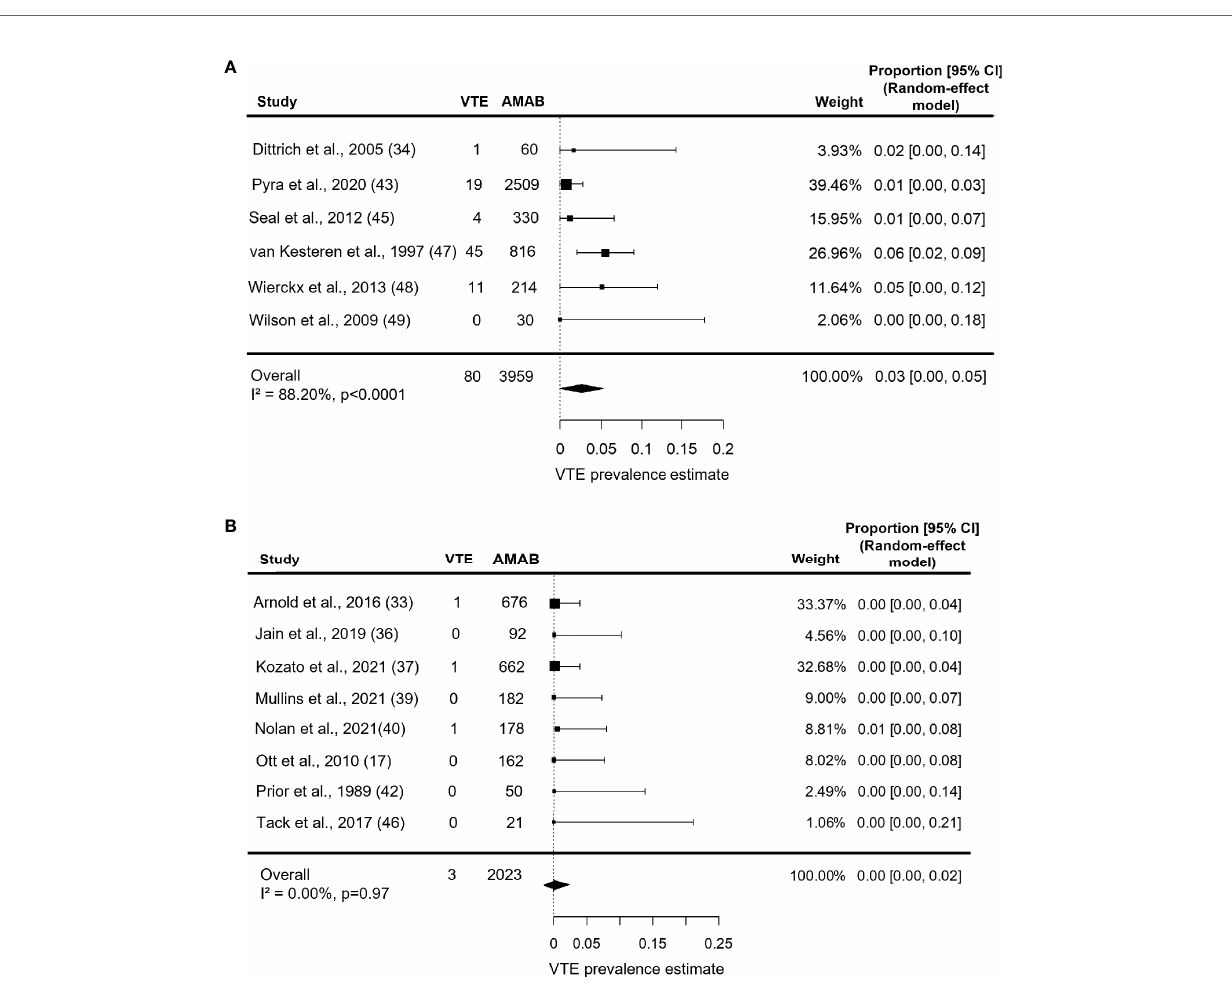
FIGURE 4 | Forest plots depicting the results of the subgroup analysis of the prevalence of venous thromboembolism (VTE) in Assigned Males at Birth (AMAB) trans people by mean age. The pooled prevalence estimate was calculated separately for studies enrolling AMAB (A) above and (B) below 37.5 years of age. Diamonds indicate the overall summary estimates and width of the diamonds represents the 95% con fi dence interval (CI); boxes indicate the weight of individual studies in the pooled